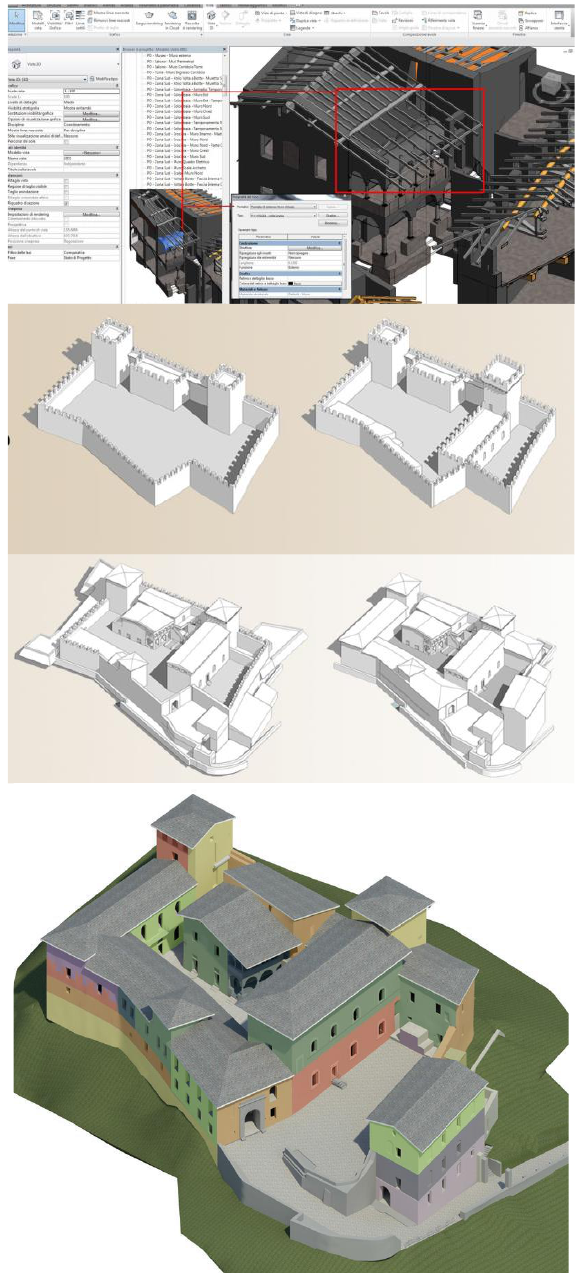
Fig. 6. A detail of the BIM in Revit, where different colours correspond to different construction